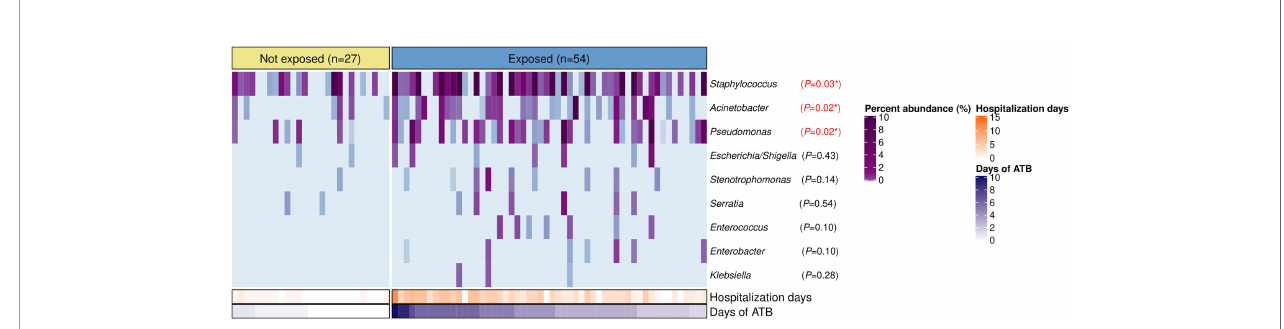
FIGURE 4 | Bacterial genera associated to nosocomial infections in the nasopharynx of patients with IPD according to antibiotic-exposure and length of hospitalization prior to sample collection. Heatmap displaying relative abundances (%) of bacterial genera with characteristic species implicated in healthcare- associated infections. Each column represents a sample, while each row a bacterial genus. Samples are split by the antibiotic-exposure group and ordered by days of antibiotic intake. Rows are sorted by total relative abundance in decreasing order. Bottom bars indicate the number of days of antibiotic exposure and days of hospitalization prior to sample collection for each patient with distinct color scales. Differences in relative abundances of these bacteria by group were assessed with Wilcoxon tests and FDR adjusted p-values are shown. Signi fi cance codes: *** ≤ 0.001; ** ≤ 0.01; *